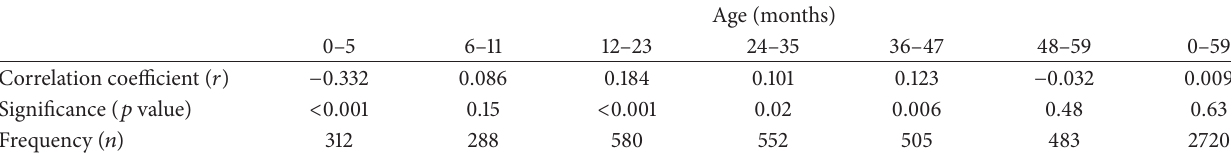
Table 4: Correlation between length-for-age 𝑍 -score (LAZ) and weight-for-length (WLZ) stratified by age